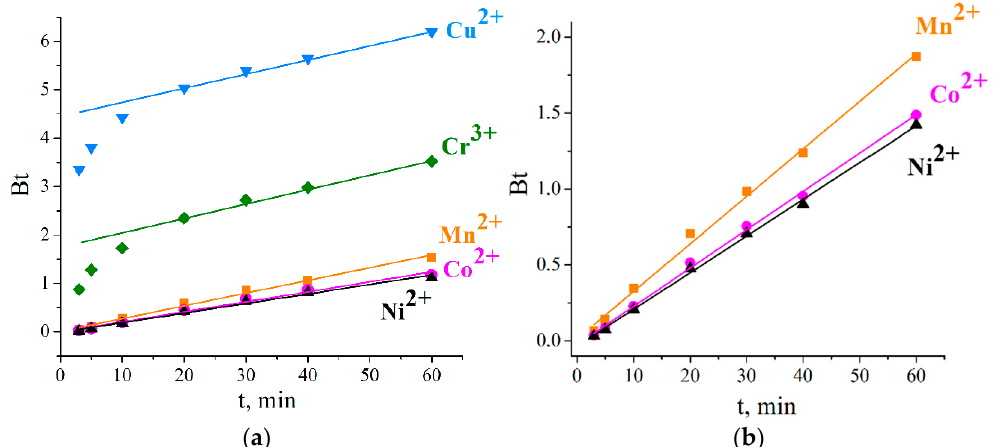
Figure 4. Boyd’s plots for Cu 2+ , Co 2+ , Ni 2+ , Mn 2+ , and Cr 3+ sorption on Li-TiOP at 298 K ( a ) and 313 K ( b ).